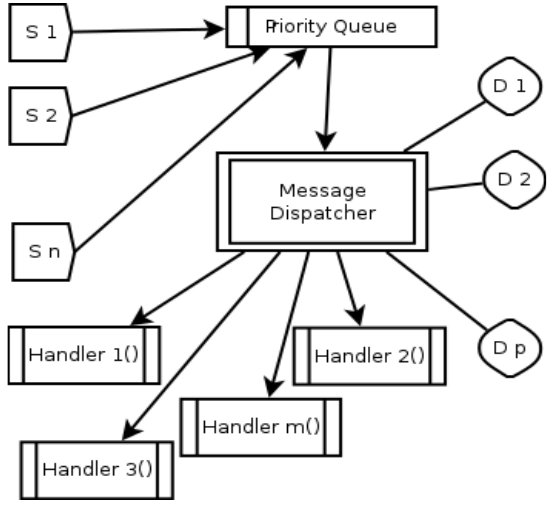
Figure 2. Dispatcher Main